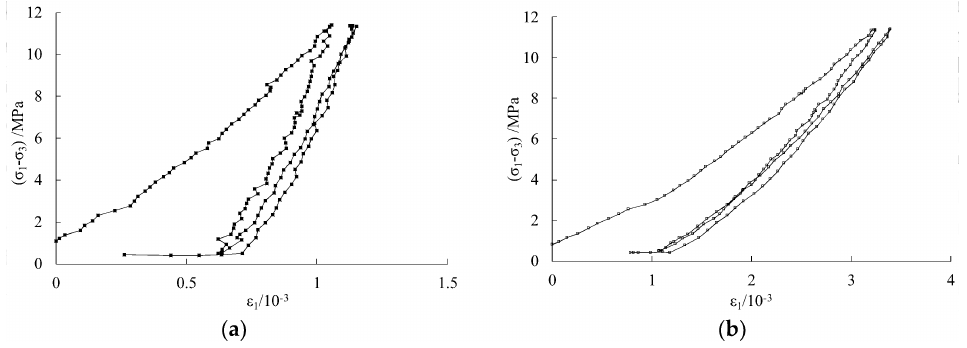
Figure 9. Deviatoric stress-axial strain curves of different specimens under low stress: ( a ) Coarse sandstone; ( b ) Coal.